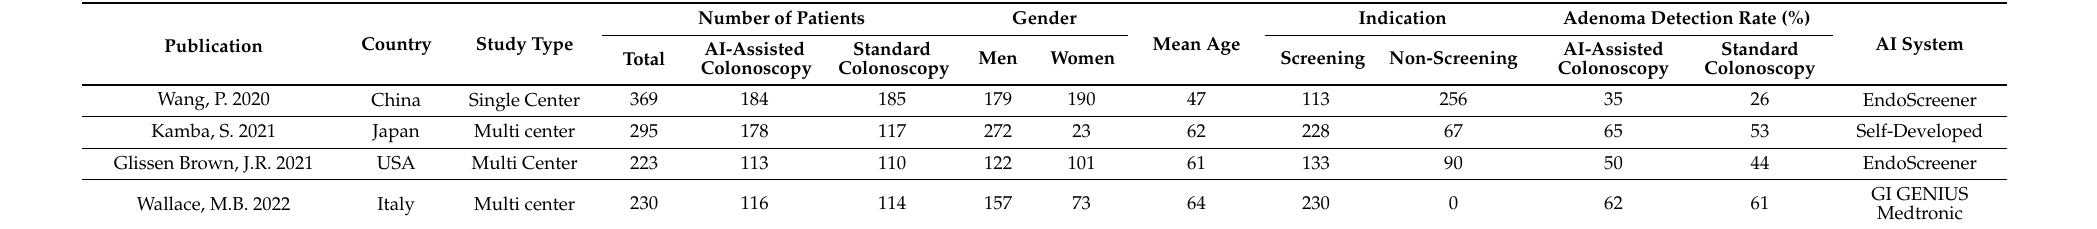
Table 2. Tandem Randomized Controlled